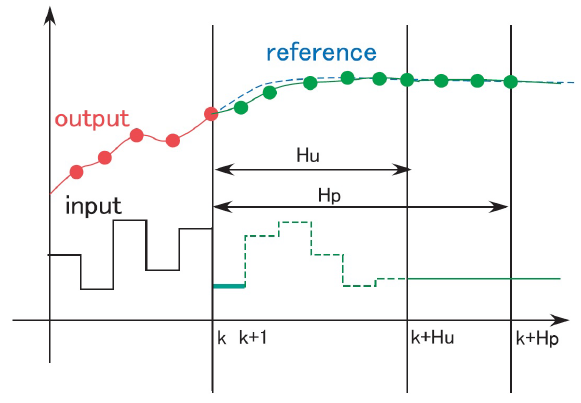
Figure 9. MPC variables, disturbances and prediction